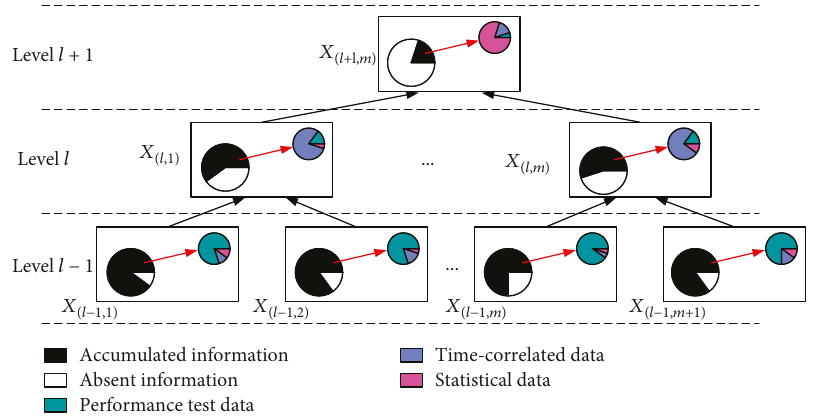
Figure 1: Graphical description of the two crucial issues existing in the MSDII